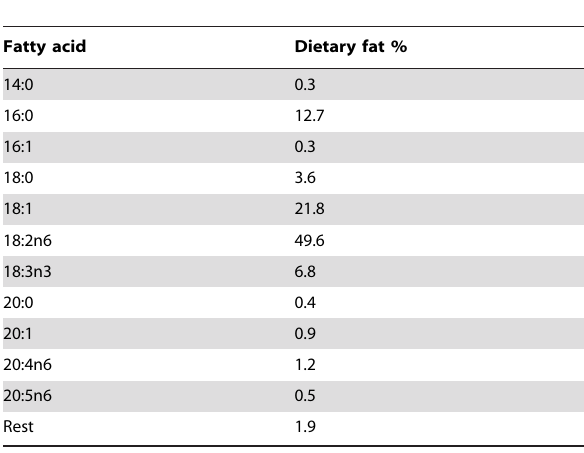
Table 1. Percent fatty acid composition of hamster chow.